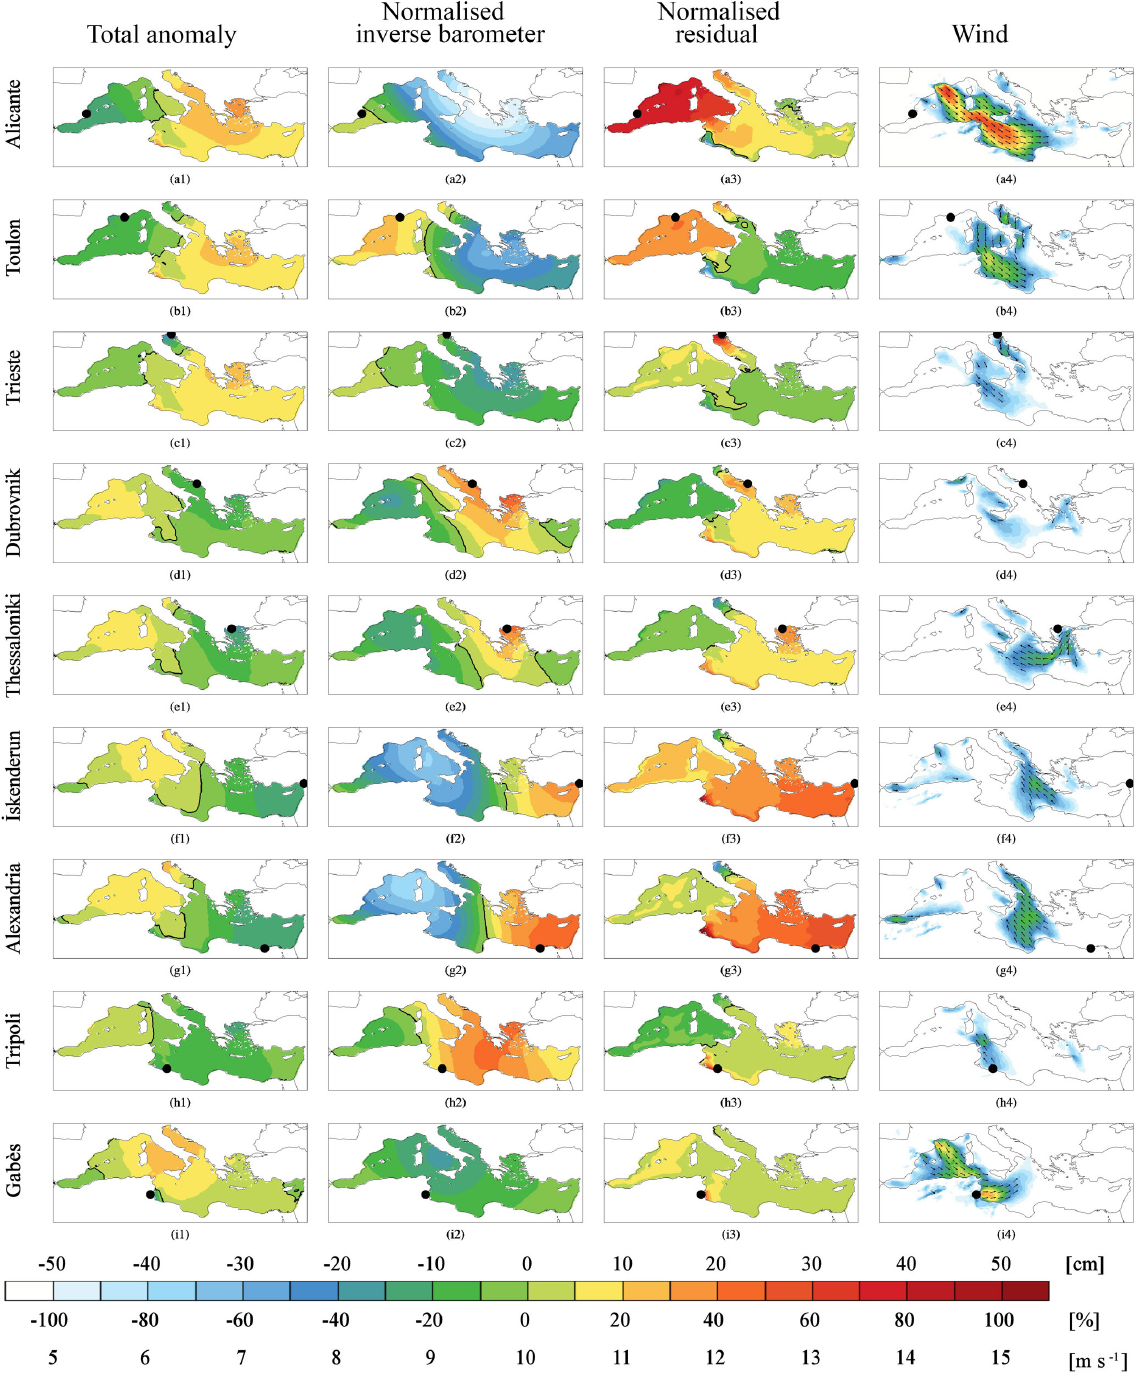
Figure 13. The same as Fig. 12 except that negative sea level anomaly events are considered (in this case the minima of the SLA total in the first column are used for producing normalised values in the second and third